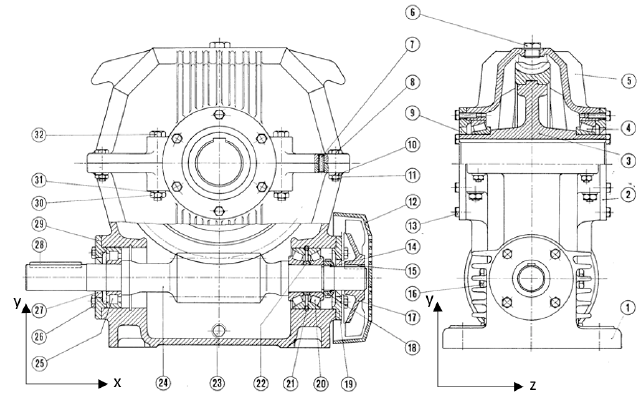
Figure 14. RV 250 gearbox with reference system.